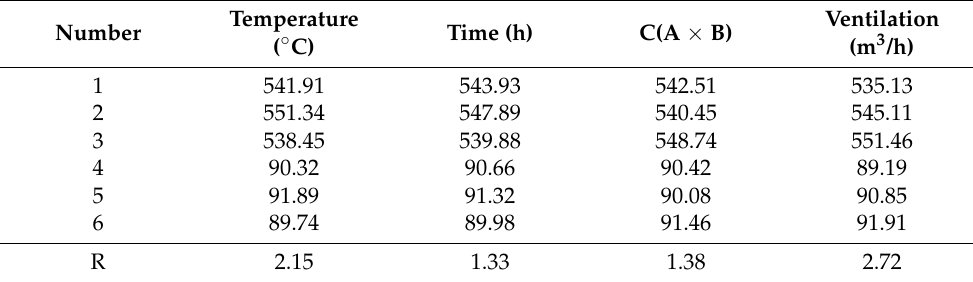
Table 6. The result of extreme difference analysis in orthogonal